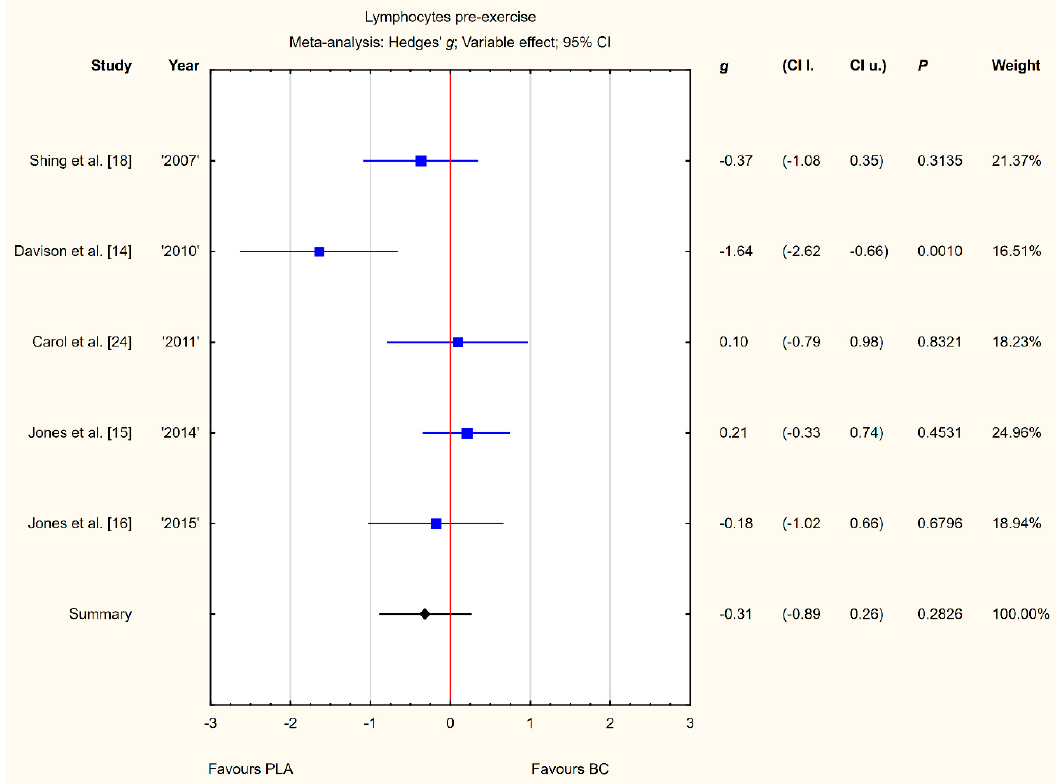
Figure 4. Forest plot of the random-effects meta-analysis of changes in lymphocytes concentration. Heterogeneity: Tau 2 = 0.27; Chi 2 = 11.13; df = 4; I 2 = 64.06%; P = 0.0252. Abbreviations: BC–bovine colostrum, PLA–placebo.